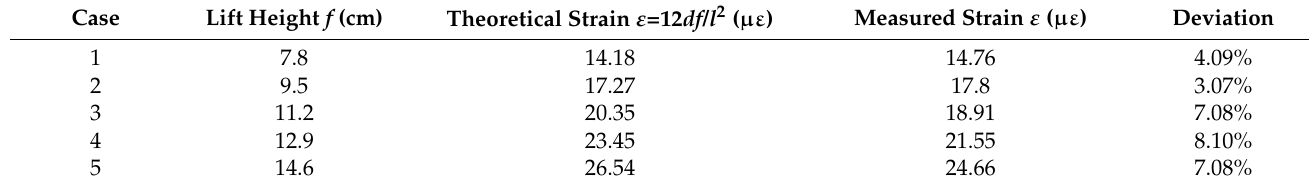
Figure 6. Lifting test on site.